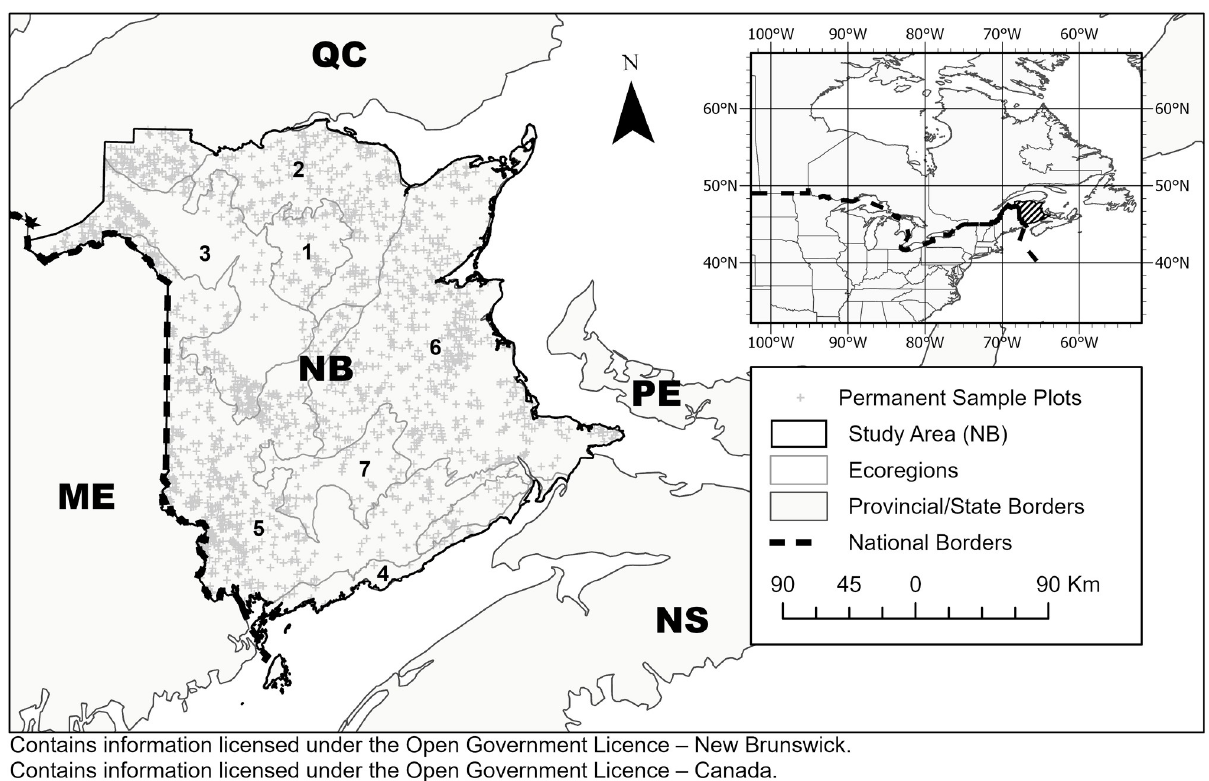
Fig 1. Location of permanent sample plots and ecoregions in New Brunswick of eastern Canada (inset). Ecoregion number in the legend corresponds to that in Table 1.